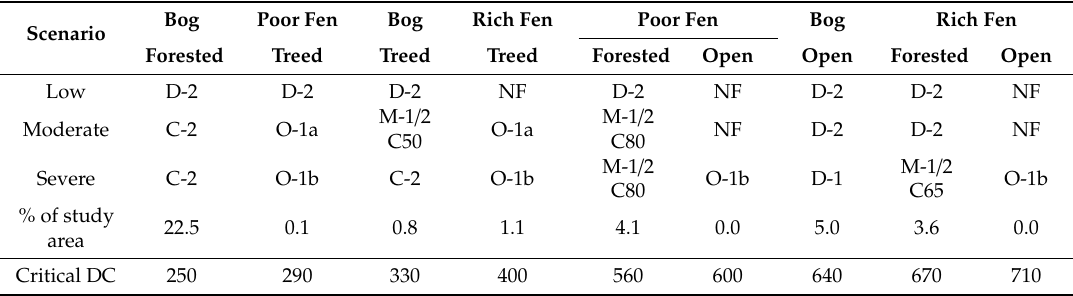
Table 1. Fuel type attribution by drought scenario and wetland type. Critical Drought Code for the modelled water table being 25 cm below the surface (open and treed rich fens with sedge cover) or 40 cm below the surface (moss and shrub surface cover, all other types) is shown in the bottom row (see Table A1). Mixedwood (M) fuel types note the conifer content (i.e. C50 as 50% conifer). See Table 2 for description of fuel types and fire spread rates. NF stands for “non-fuel” and indicates a peatland ecosystem in a hydrological state with extensive standing water. All other fuel types will allow at least minimal fire spread